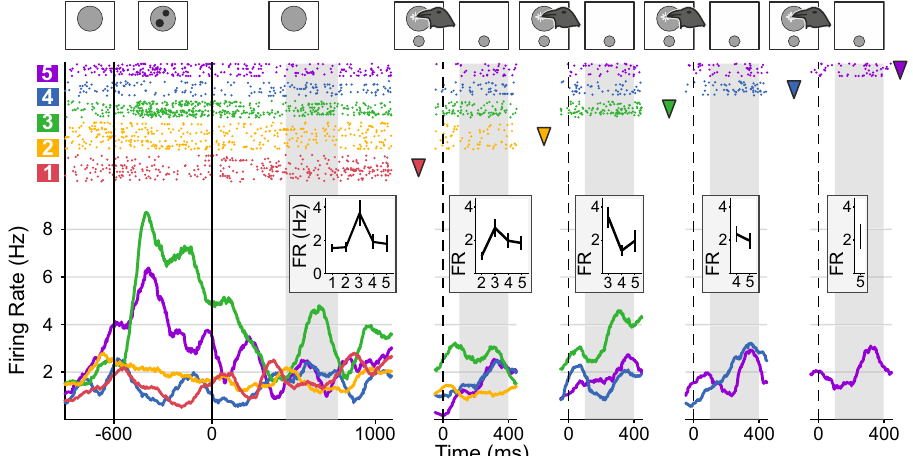
Fig. 7 | Neuronal activity of an exemplary neuron throughout the entire trial. Exemplary neuron selective to numerical value 3 throughout an entire trial. Dot raster histogram, spike-density functions, and color code are the same as in Fig. 3c – g. Pictograms above the dot raster histograms show the respective task period. Because the time intervals between the crow ’ s unitary responses in the motor execution period varied (see our timing controls for the different arrange- ments), the execution responses are temporally interrupted; trials are temporally